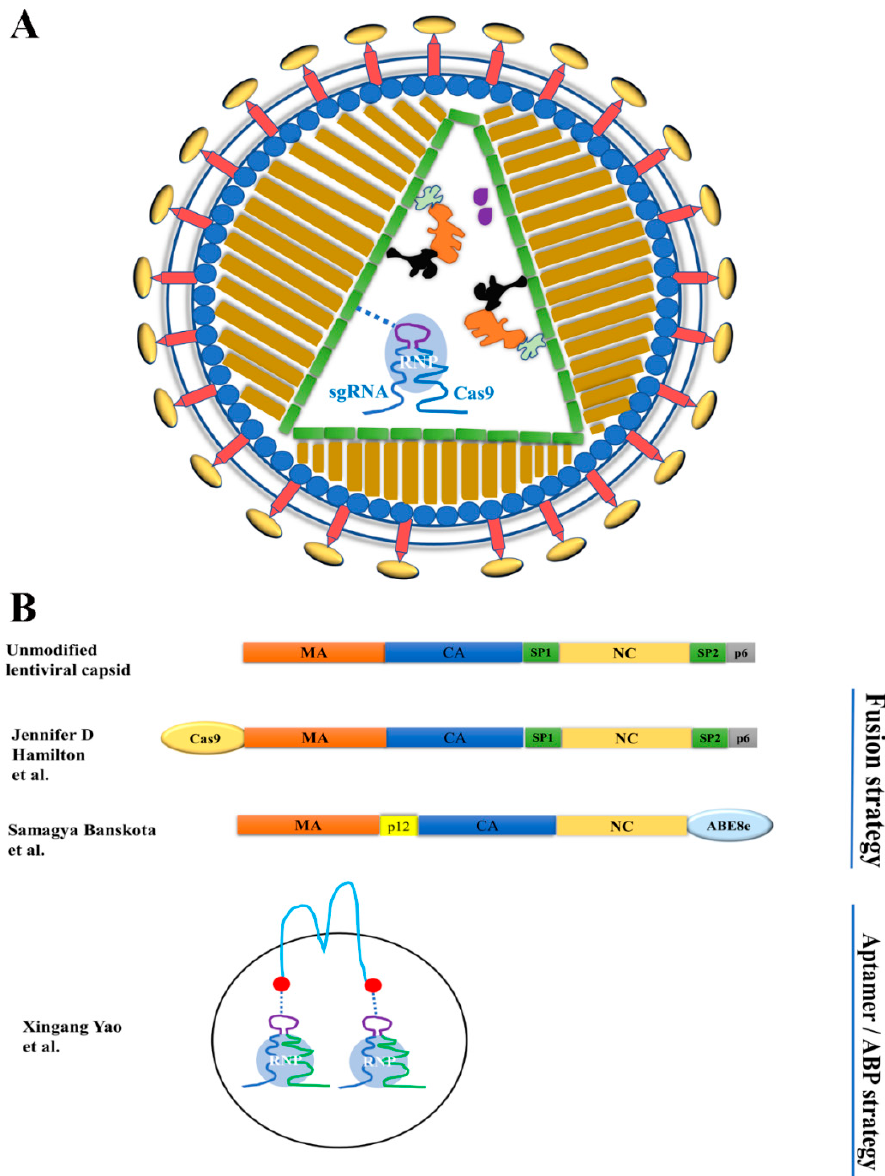
Figure 2. Strategies for modifying the Gag protein for designer nuclease RNP delivery by VLPs. ( A ) Diagram illustrating protein- or RNP-delivering VLPs. The RNA, if present, does not contain a long terminal repeat, so reverse transcription cannot happen. ( B ) Strategy for packaging proteins and RNPs into extracellular vesicles. A dashed line indicates non-covalent interactions. The VLPs and exosomes were reported in references [5], [10] and [12]